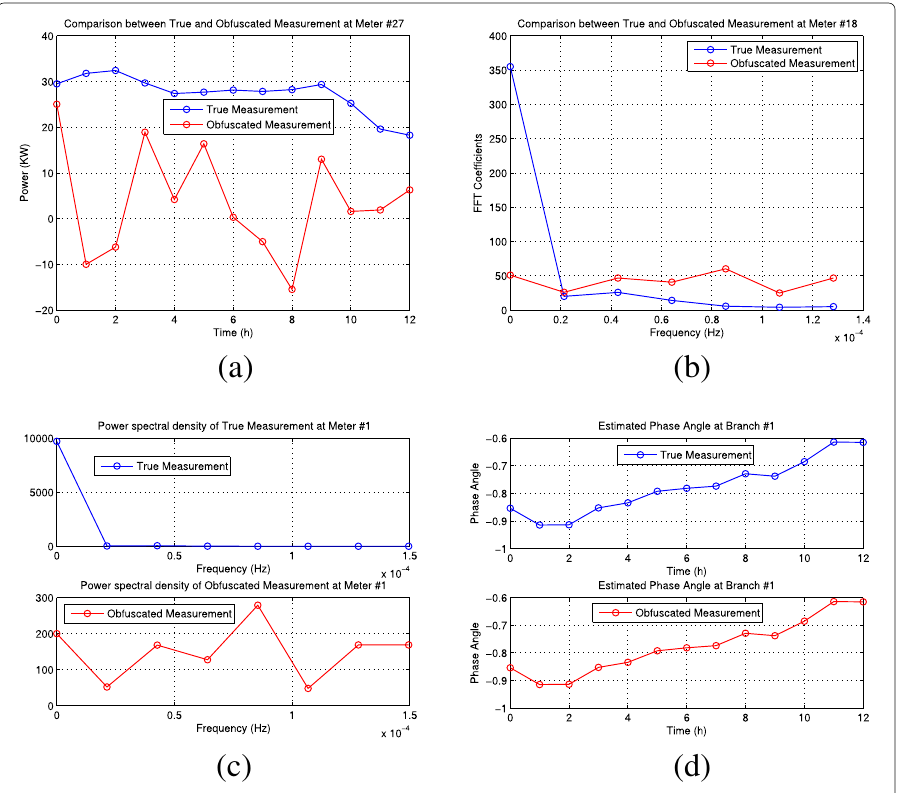
Fig. 5 Illustration of data obfuscation in IEEE 14-bus power network. a Original and Obfuscated Time Domain Data from Meter #27. b Original and Obfuscated Frequency Domain Data from Meter #27. c Power Spectral Density of True and Obfuscated Measurement Data. d Estimate State Value at Branch #7. Estimation error between true and obfuscated dataset = 0